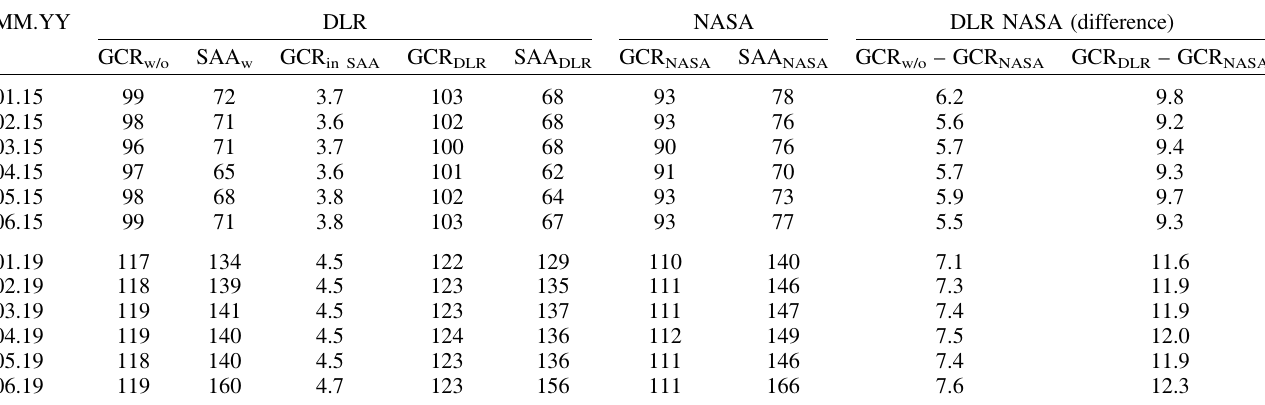
Note: All dose values in l